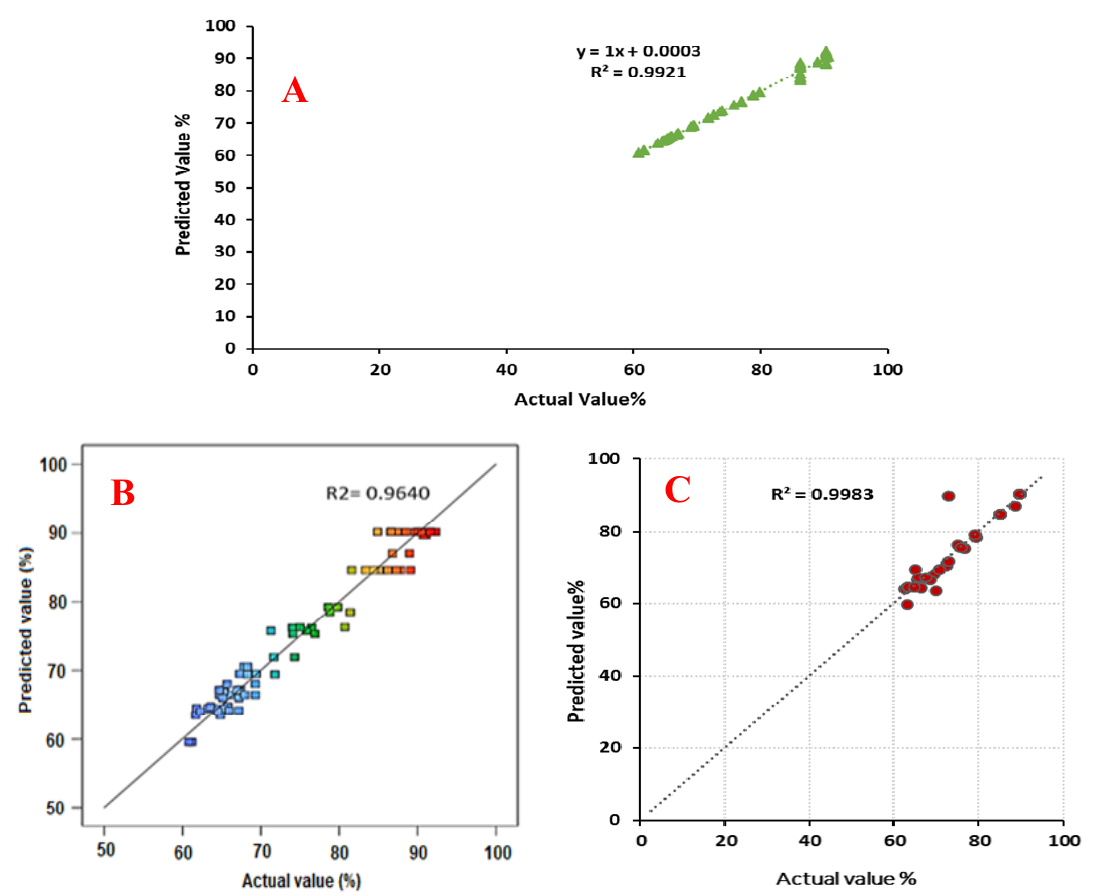
Figure 7. ( A ) Regression plot for ANFIS model (actual vs. predicted), ( B ) regression plot (actual vs. predicted) for ANN model, ( C ) regression plot (actual vs. predicted) for RSM